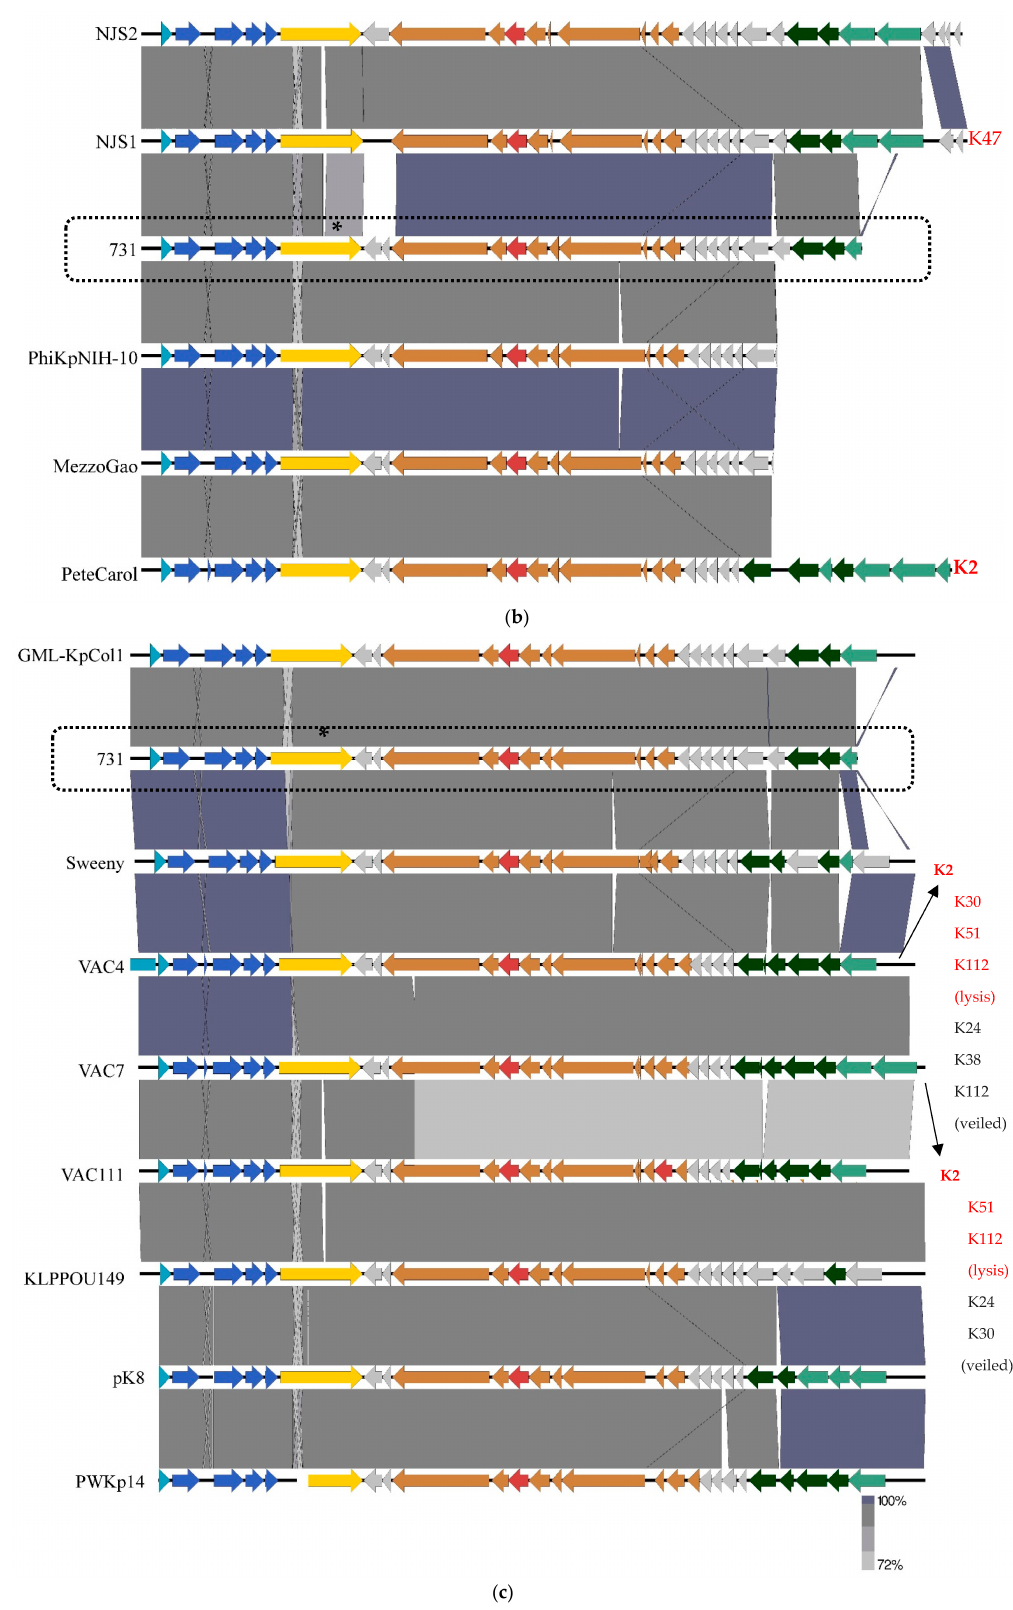
Figure 6. Genome similarities and differences of phage 731 to the representatives of the K. pneumoniae phages of the Webervirus genus. ( a ) Comparison of phages Sushi, 731, vB_KpnS_SegesCirculi, vB_KpnS_Domnhall and vB_KpnS_KingDDD. ( b ) Comparison of phages NJS2, NJS1, 731, PhiKpNIH-10, MezzoGao and vB_KpnD_PeteCarol. ( c ) Comparison of phages GML-KpCol1, 731, Sweeny, vB_KpnS-VAC4, vB_KpnS-VAC7, vB_Kpn-VAC111, vB_KpnS_15- 38_KLPPOU149, pK8 and PWKp14. Genomes of the phages are truncated to the tail regions, containing putative depolymerases. Phage names are indicated on the left. Capsule specificities, where known, are written on the right. Phage 731 is framed and orf22 is marked with an asterisk (*). The provided ORF numbering was used only in this study for practical reasons and is indicated on ( a ), predicted ORF functions are grouped, and their color codes are also indicated. Annotations of the genomes were performed by the RAST server and were visualized by Easyfig. Phages are listed in Table 2. 3.5. Molecular Properties of the Putative Phage Depolymerase